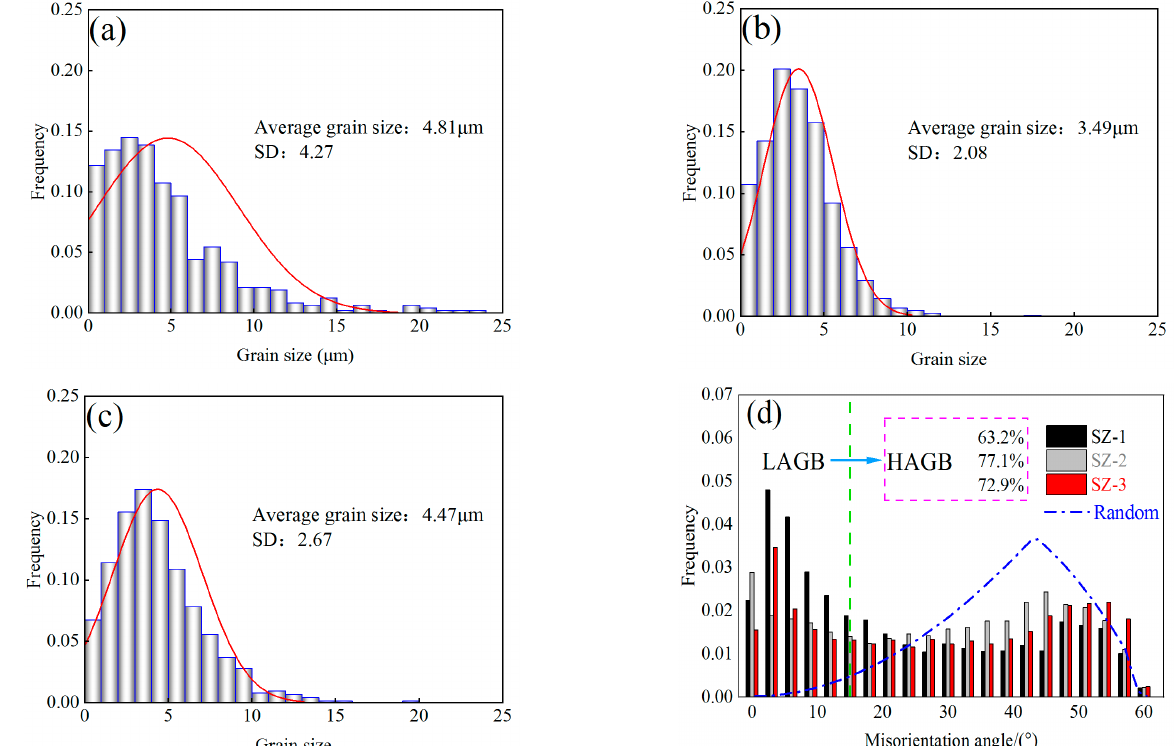
Figure 5. ( a – c ) Average grain size and ( d ) misorientation angle distributions of